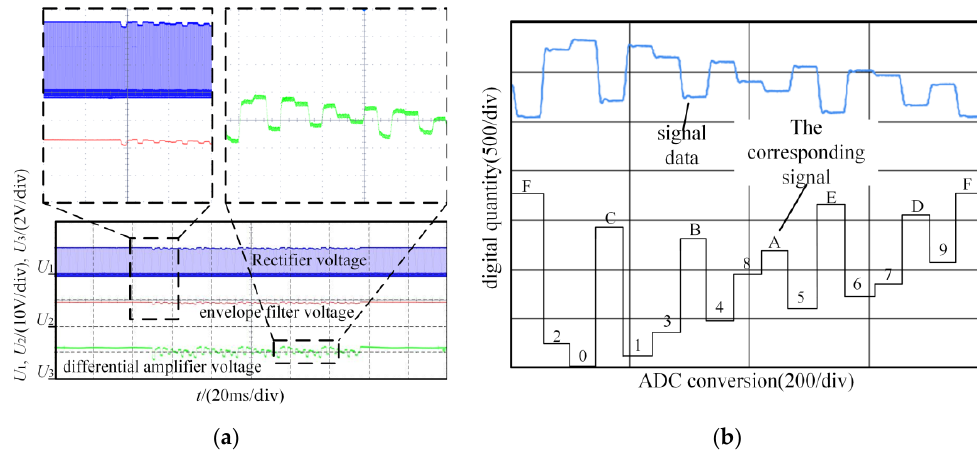
Figure 10. A 750 baud rate 16ASK modulation information transmission diagram: ( a ) Demodulation circuit waveform; ( b ) ADC conversion voltage data diagram.